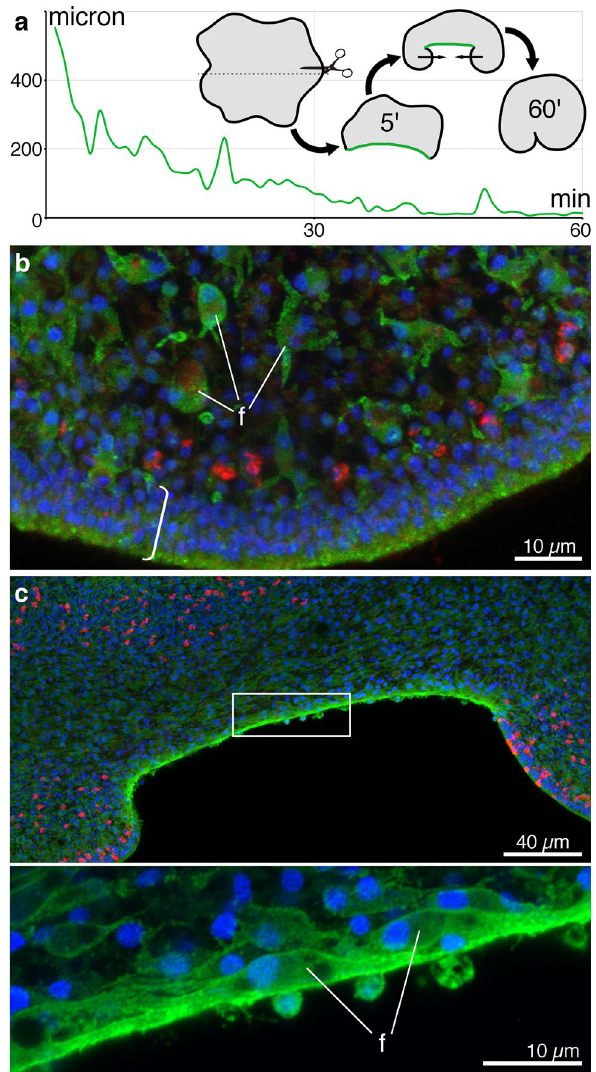
Figure 6. Fiber cell involvement in wound healing in Trichoplax . ( a ) Graph illustrating the time course of wound closure in a cut animal (wound length versus time) and a scheme of the experiment and stages of wound healing. Animals were cut in half. Five minutes after cutting, the wounded area (green) was slightly invaginated. The wound margins curled inwards and gradually became closer with intermittent reopenings. The margins met and fused by ~ 60 min, leaving a notch marking the site of the wound. ( b , c ) Fluorescence staining for fiber cells (anti-FC, green), mucocytes (WGA, red), and nuclei (Hoechst, blue) in intact and wounded Trichoplax . ( b ) In intact Trichoplax , tightly packed epithelial cells form a rim (bracket) around the circumference of the body. A row of mucocytes resides within the rim or close inside. Fiber cells (f) are arrayed in the interior starting ~ 10 µm from the edge. ( c ) In wounded Trichoplax , fiber cells are aligned along the wound and are more tightly packed and intensely stained than fiber cells in the interior or in intact animals. Inset (framed region) shows magnified view of fiber cells aligned along the